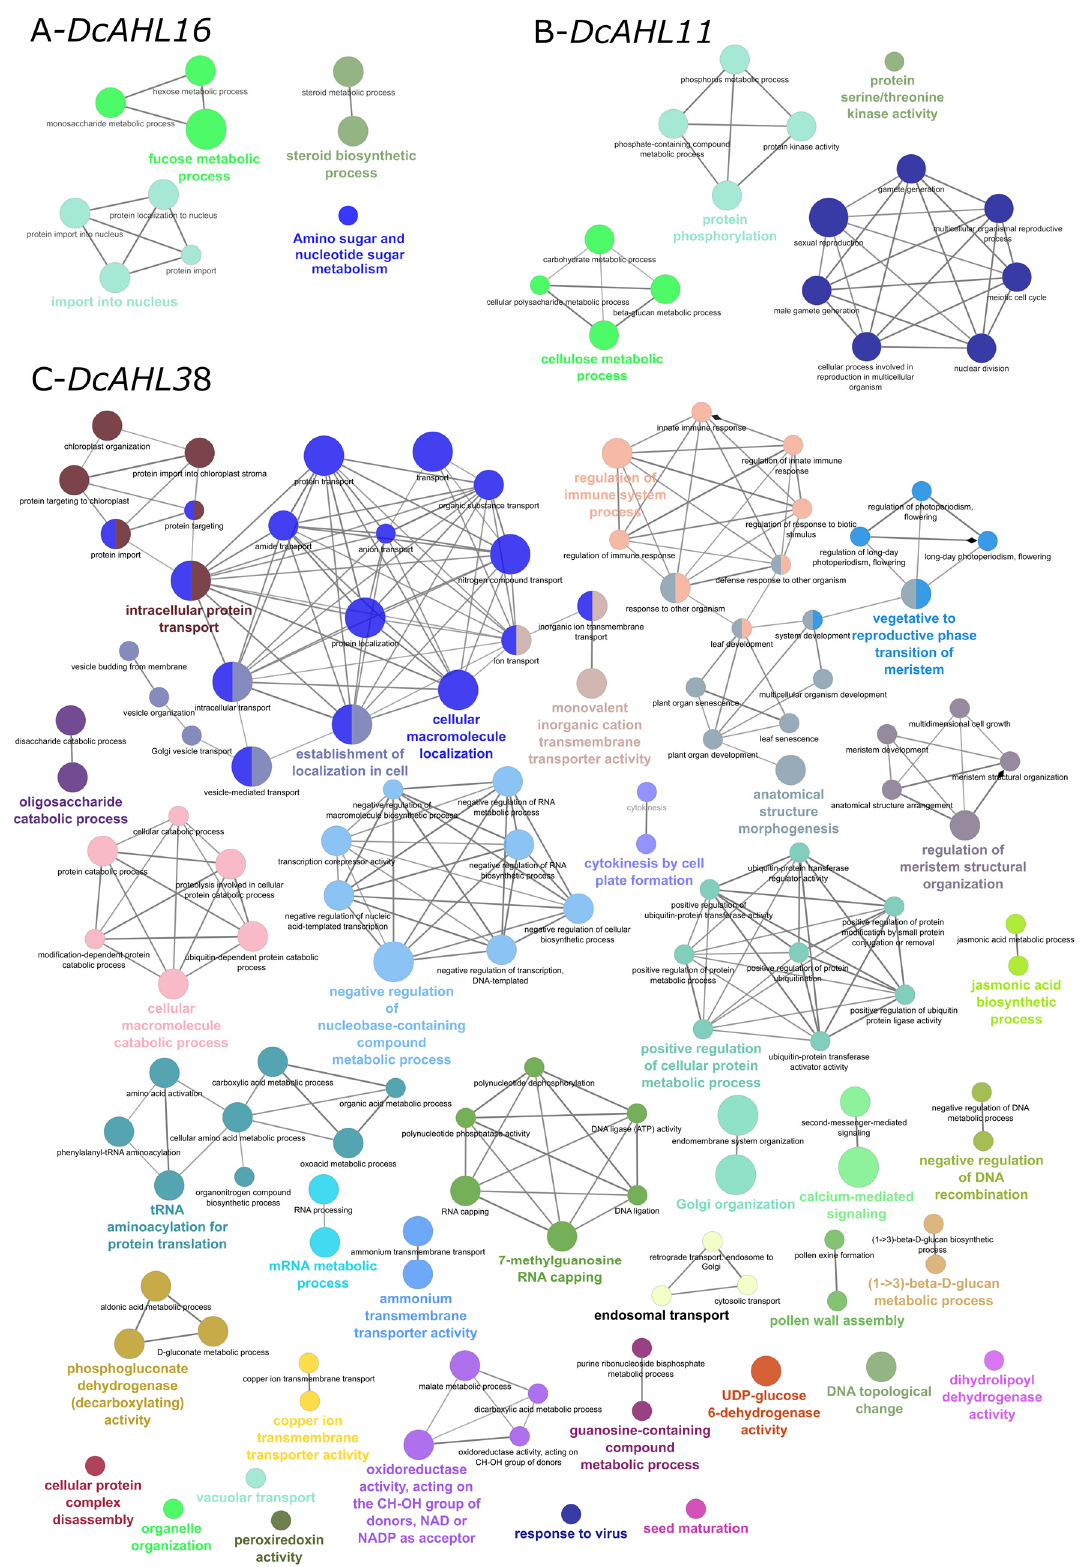
Figure 6. GO enrichment results for carrot genes possibly interacting with DcAHL16 ( A ); DcAHL11 ( B ); DcAHL38 ( C ). Sizes of circles show the number of genes corresponding to GO terms.